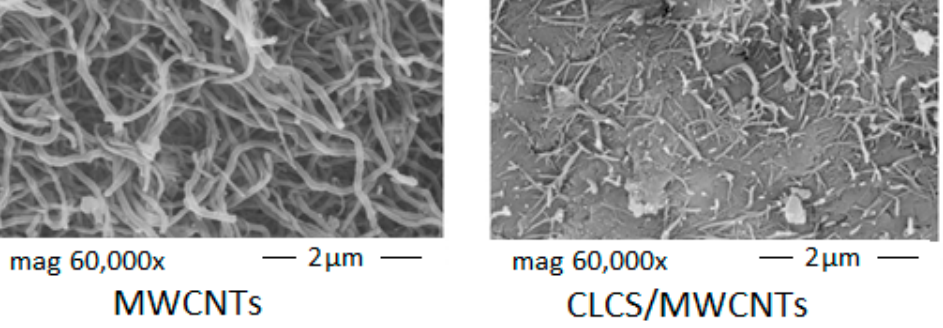
Figure 4. SEM images of MWCNTs and CLCS/MWCNTs composite at a magnification of 60,000× .